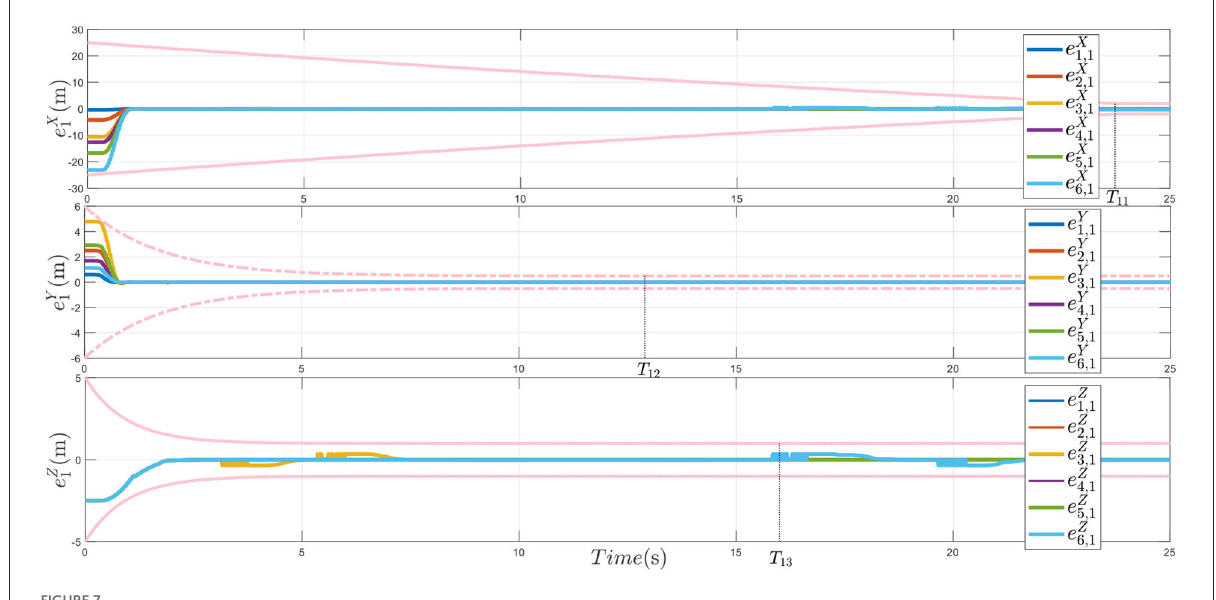
FIGURE7 The formation tracking error e 1 .